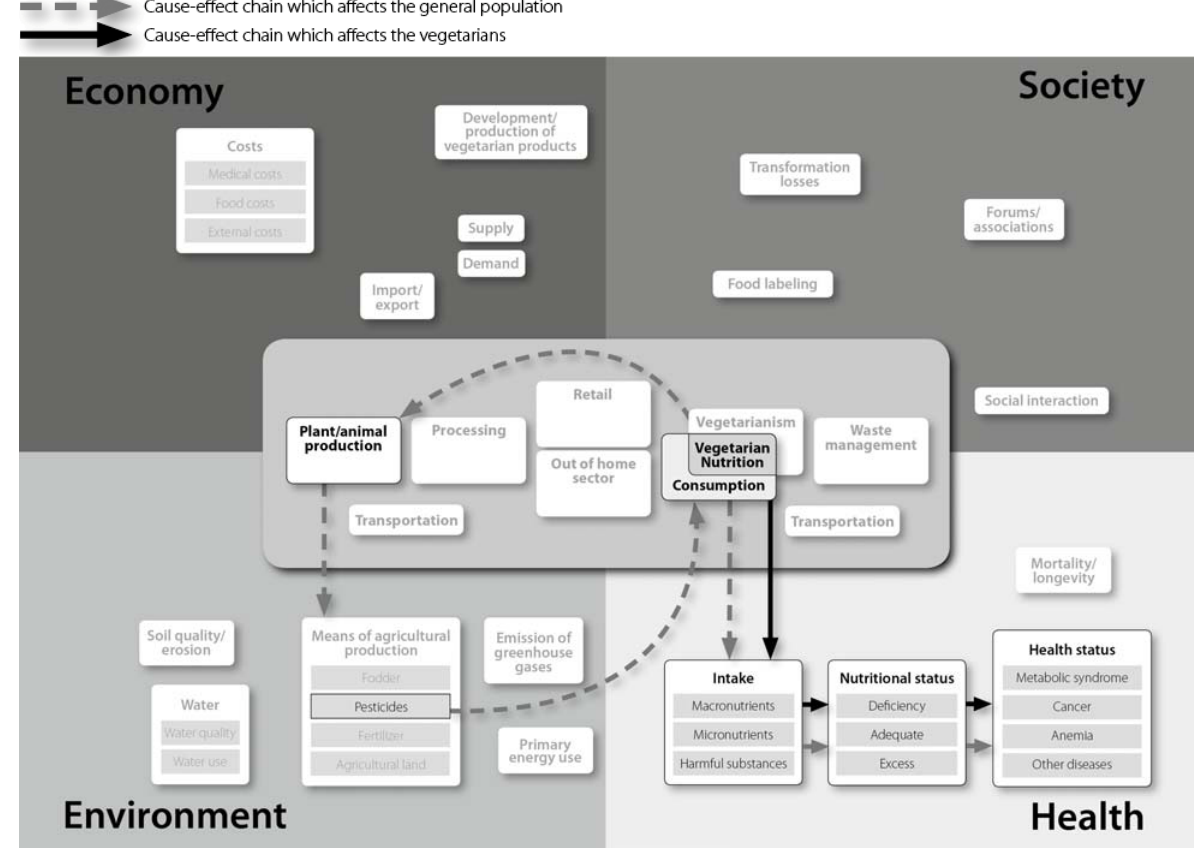
Figure 3. Example for the effects of vegetarian nutrition, which happen in parallel and may affect vegetarians as well as the general